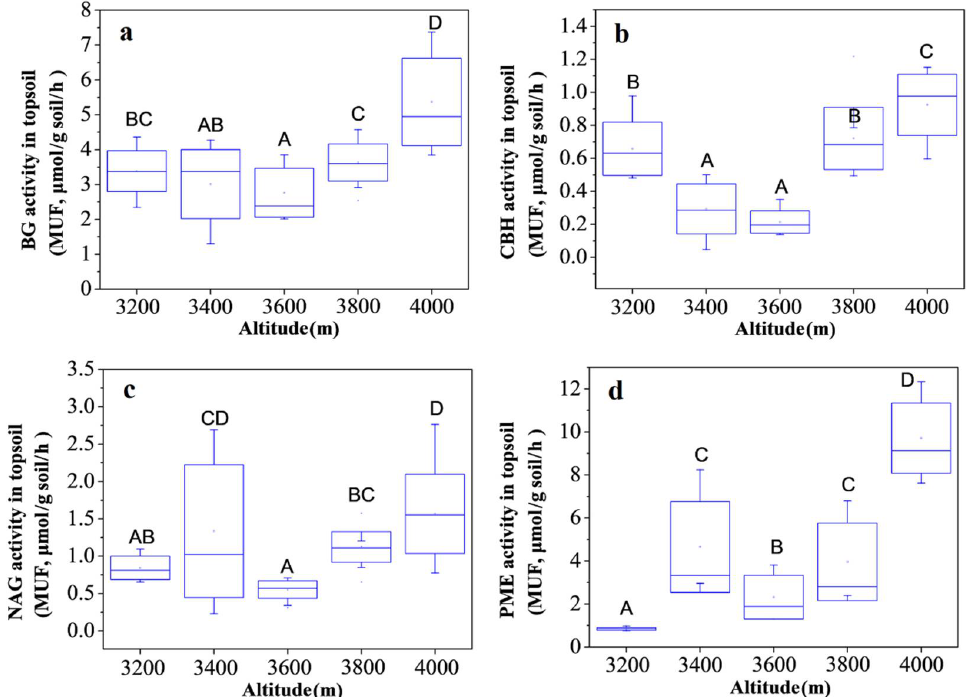
Figure 1. Soil enzyme activity in the topsoil (0–10 cm) along the altitudinal gradient of Mengbi Mountain: ( a ) BG = β -glucosidase, ( b ) CBH = cellobiohydrolase, ( c ) NAG = β -N-acetyl-glucosaminidase, and ( d ) PME = phosphomonoesterase. Different capital letters indicate significant ( p < 0.05) differences at different altitudes in one-way analysis of variance (ANOVA) based on Duncan’s comparison procedure (the same in Figure 2).